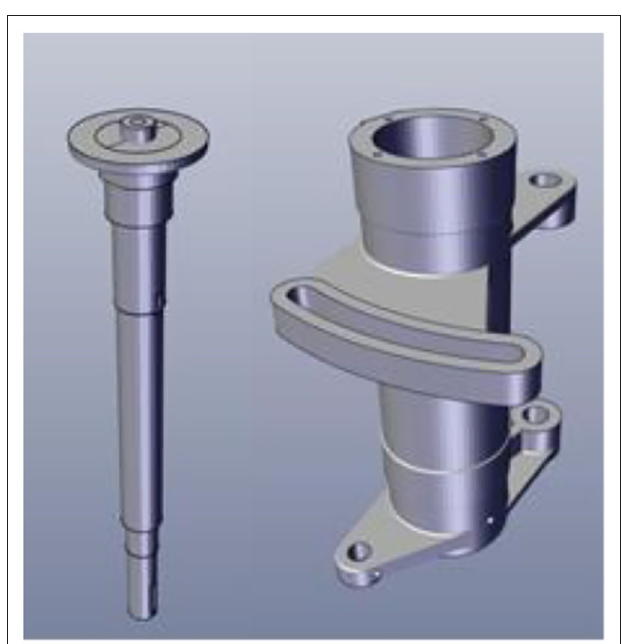
FIGURE 7 | 3D model of spindle and spindle